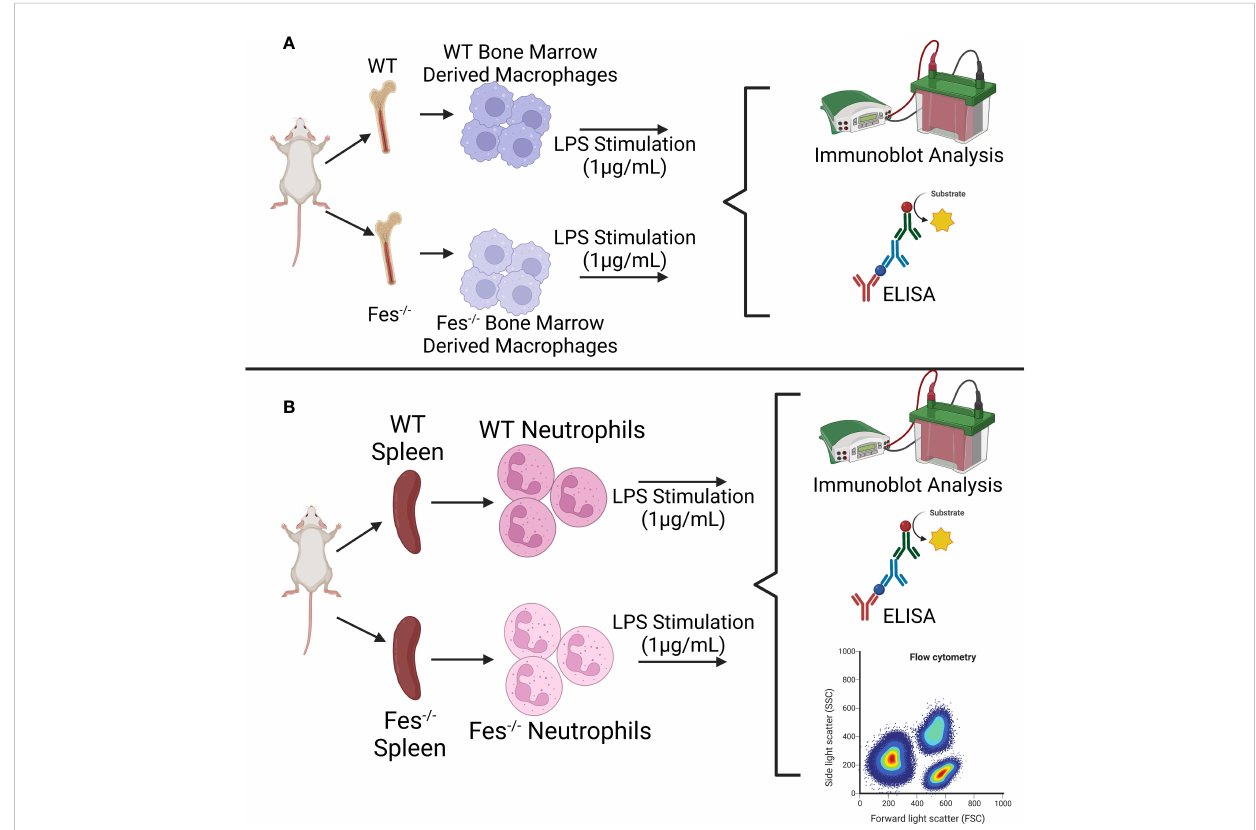
FIGURE 3 Graphical depiction of in vitro methodology. (A) Wildtype (WT) or FES -/- bone marrow derived macrophages will be stimulated with LPS or other stimulating agents and analyzed for differential signaling cascade activation (immunoblot analysis) and cytokine production (enzyme-linked immunosorbent assay (ELISA)). (B) WT or FES -/- neutrophils isolated from the spleen will be stimulated with LPS or other stimulating agents and analyzed for differential signaling cascade activation (immunoblot analysis), cytokine production (ELISA), and neutrophil extracellular trap formation ( fl ow cytometry). The same methodology will be followed with the addition of decitabine and lorlatinib. Created with